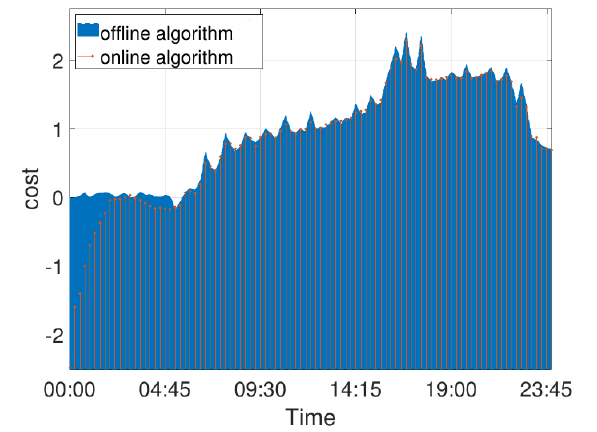
Figure 7. Cost comparison between the offline [30] and online algorithms solving the distributed OPF.